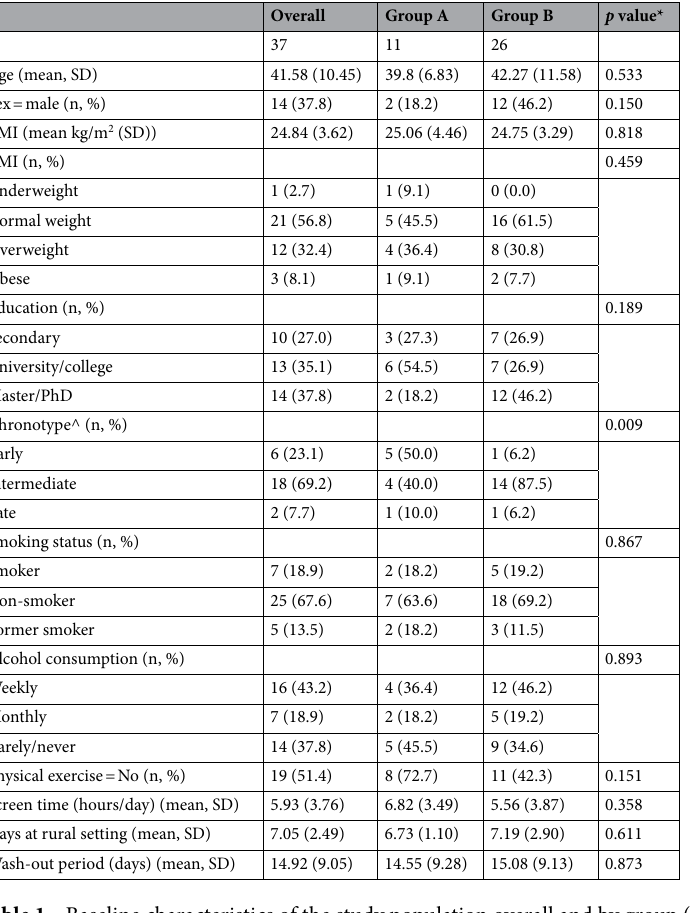
Table 1. Baseline characteristics of the study population overall and by group (Group A: first urban, Group B: first rural). *The above were tested for differences between the two groups by Fisher’s Exact test for categorical variables and t-test for normally distributed continuous variables. ^the chronotype categories cut-offs are: early (< 3:00), intermediate (3:00–5:00) and late (> 5:00) 42 .